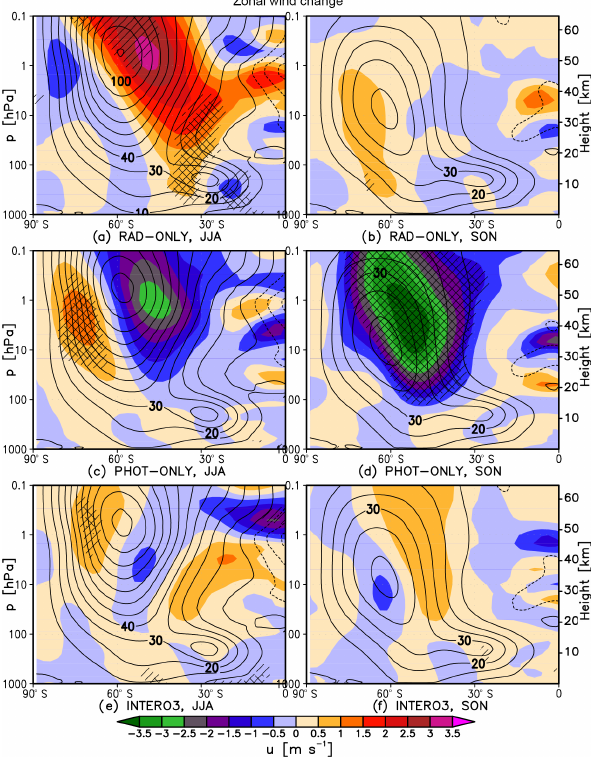
Figure 3. Shading: seasonal mean (left: JJA, and right: SON) SH zonal mean zonal wind change (ms − 1 ) between SMAX and SMIN for (a, b) RAD-ONLY, (c, d) PHOT-ONLY and (e, f) INTERO3. Single and double hatching indicate statistical significance at the 90% and 95% confidence level, respectively ( t test). Contours show the corresponding climatological seasonal mean zonal mean zonal wind for the respective SMIN run; contour spacing is 10ms − 1 .